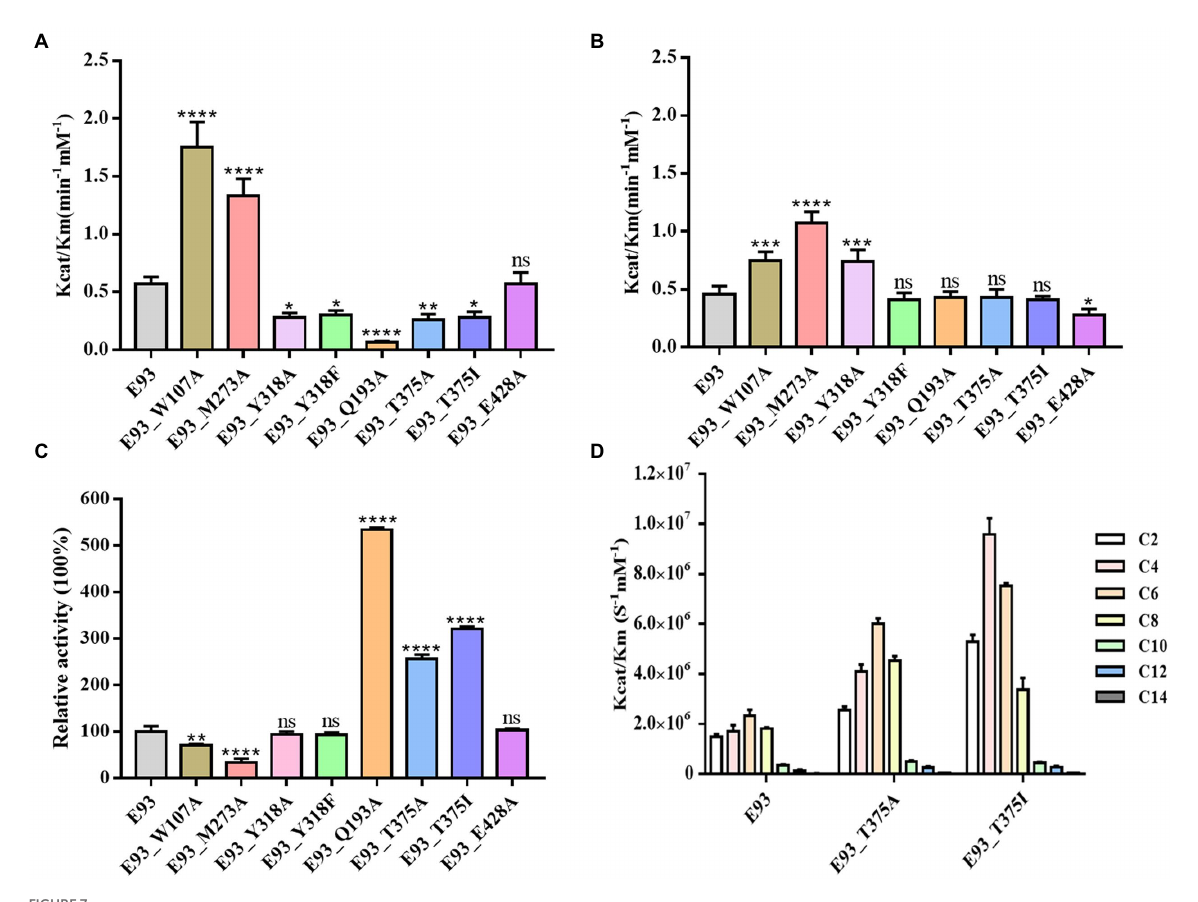
FIGURE 7 Mutagenesis analysis of key residues involved in hydrolyzing CPT11, NPC, and p -NP hexanoate (C6). Comparison of the hydrolytic activities of each mutant for CPT11 (A) , NPC (B) and p -NP hexanoate (C6) (C) . The activity of wild-type E93 was taken as 100% for panel (C) . (D) Catalytic activity of wild-type E93, E93_T375A, and E93_T375I on p -NP ester substrate hydrolysis. The data showed in panels (A–D) is from triplicate experiments (mean ± SD). * p < 0.05, ** p < 0.01, *** p < 0.001, **** p < 0.0001, and ns, not